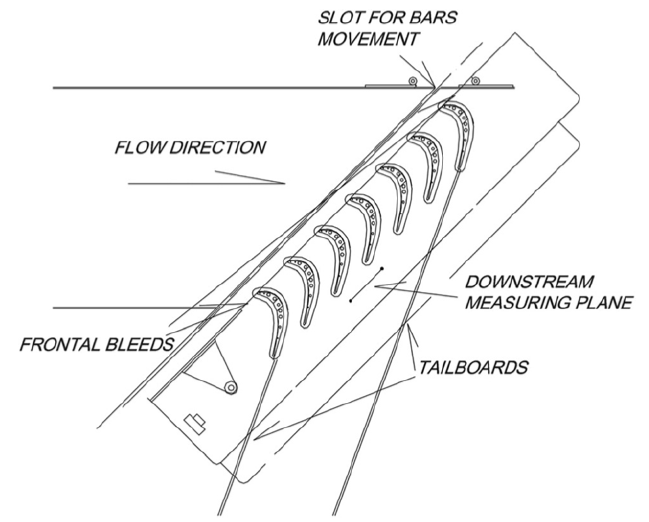
Figure 1. Sketch of the test